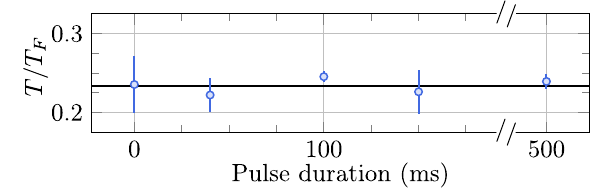
FIG. 5. Reduced temperature as a function of the rf pulse duration. The temperature is extracted from one-dimensional momentum distribution measurements fitted by a homogeneous Fermi-Dirac distribution. We observe no increase in T=T up to F 500 ms, and this holds true also for T alone. Note that the data in this figure are taken at slightly different conditions than the one in ≈ 0 . 23 . The meas- Fig. 4, with N ≈ 131 × 10 3 atoms at T=T F urement is performed at a magnetic field of B ¼ 209 . 18 G, where the atoms are very weakly interacting. The Rabi frequency is Ω = 2 π ≈ 10 . 5 kHz. Error bars represent one standard error of the F ¼